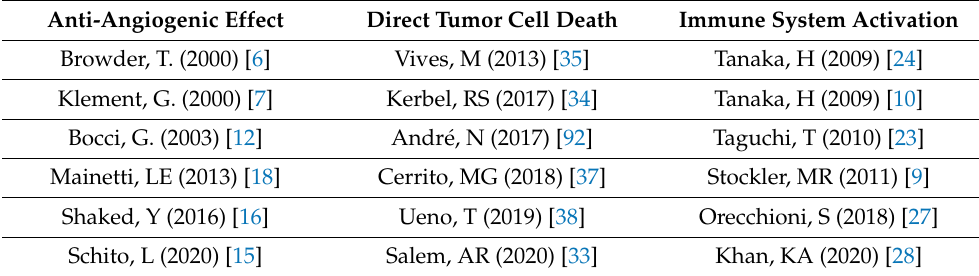
Table 1. Summarizes the contributions of different Authors in understanding the mechanisms of action of